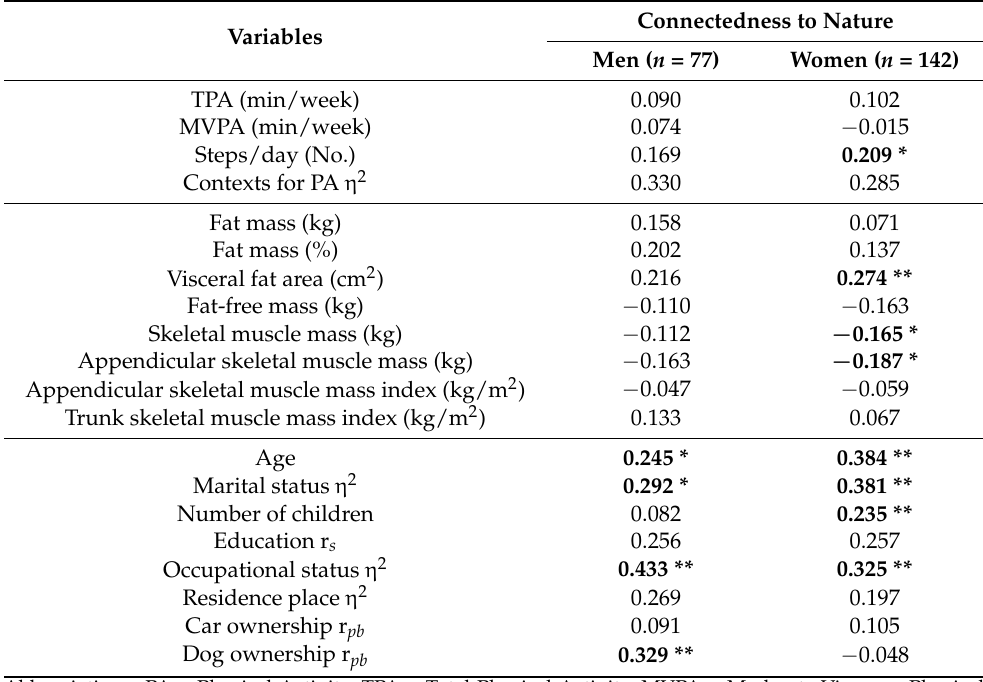
Table 3. Association between connectedness to nature with PA, body composition and demo- graphic